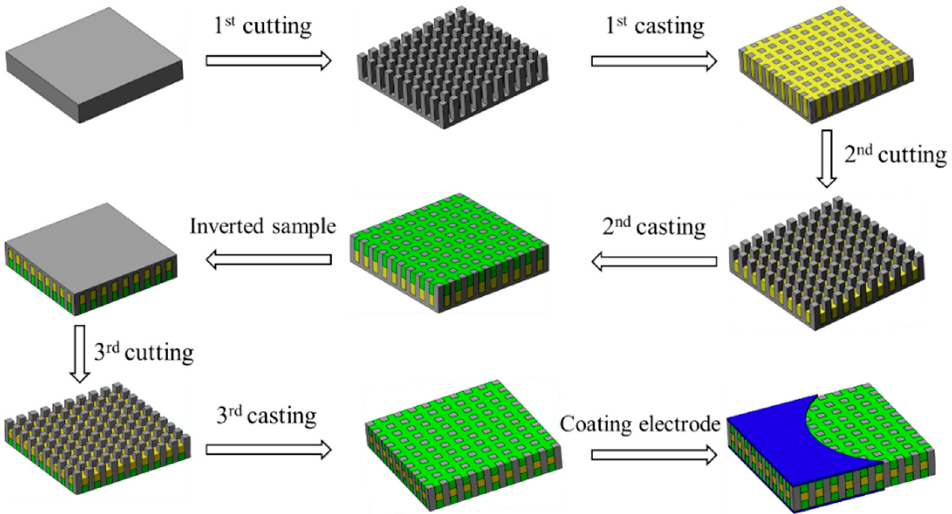
Figure 6. Preparation process of the novel composite.